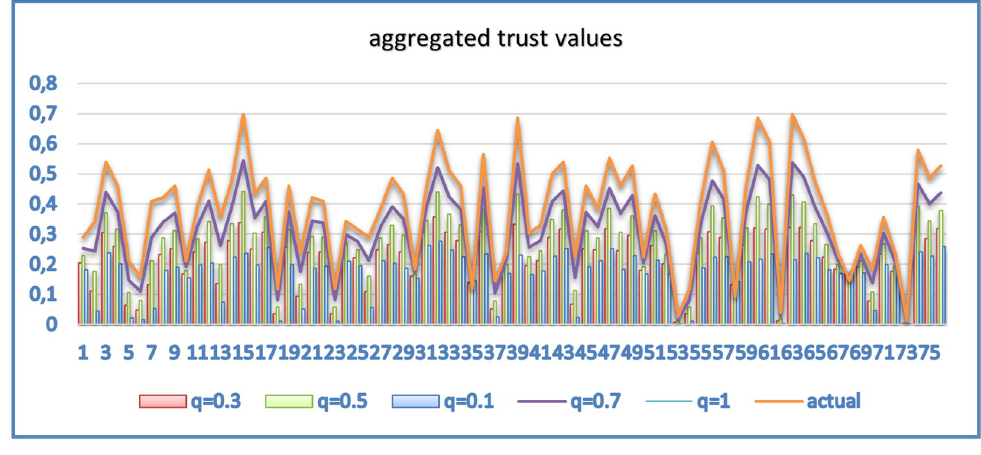
Fig 9. Aggregated trust values for different q